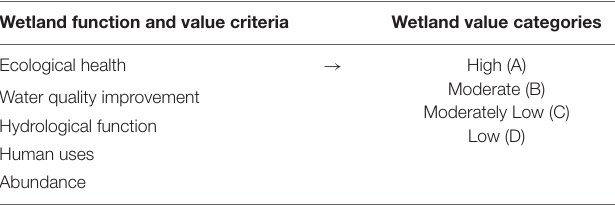
TABLE 1 | Wetland value criteria used to estimate wetland value categories. Wetland function and value criteria Wetland value categories Ecological